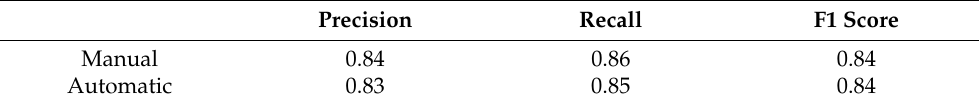
Table 6. Overall results of textural analysis of the groups for the manually and the automatically extracted CSA texture.